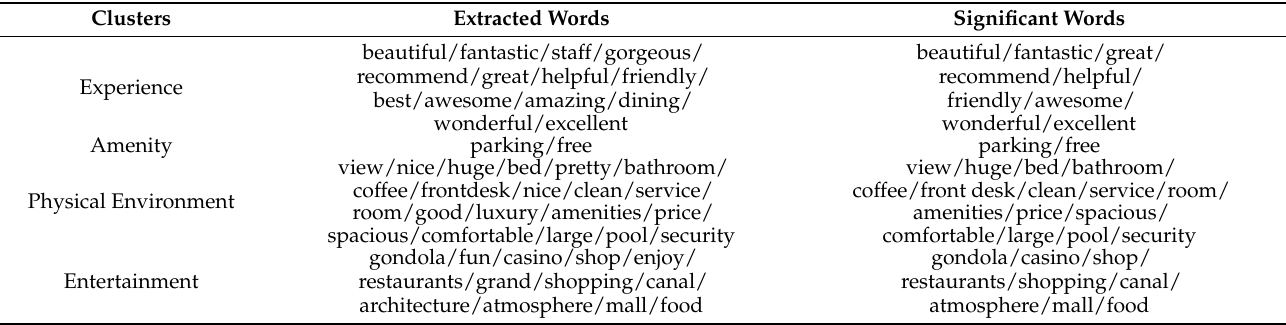
Table 4. Result of CONCOR analysis (Las Vegas).